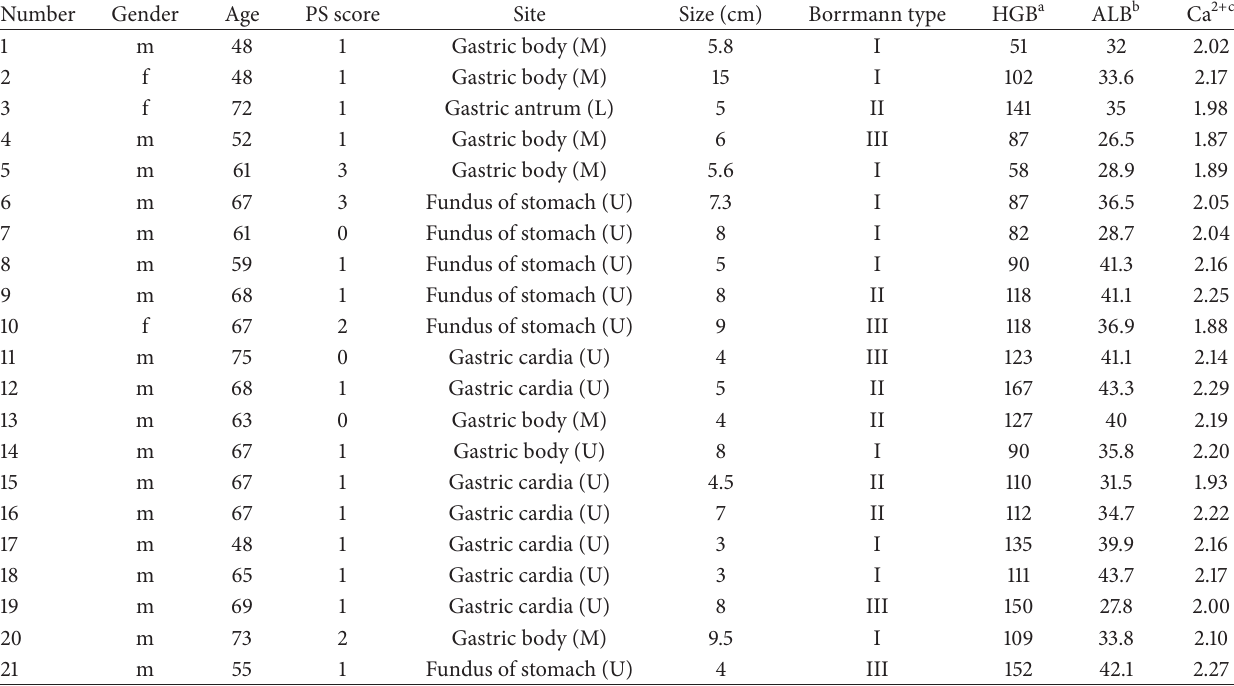
Table 1: Clinicopathological characteristics and demographical data of 21 patients with